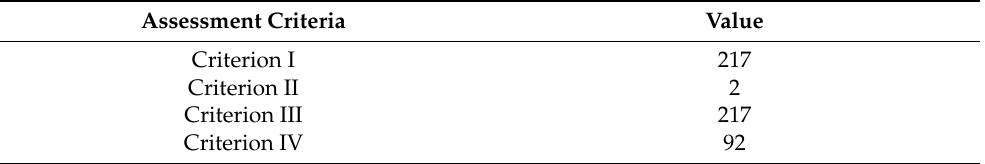
Table 1. The values of the assessment criteria for the structure with N = 7 neurons and G = 14 samples of the input vector.